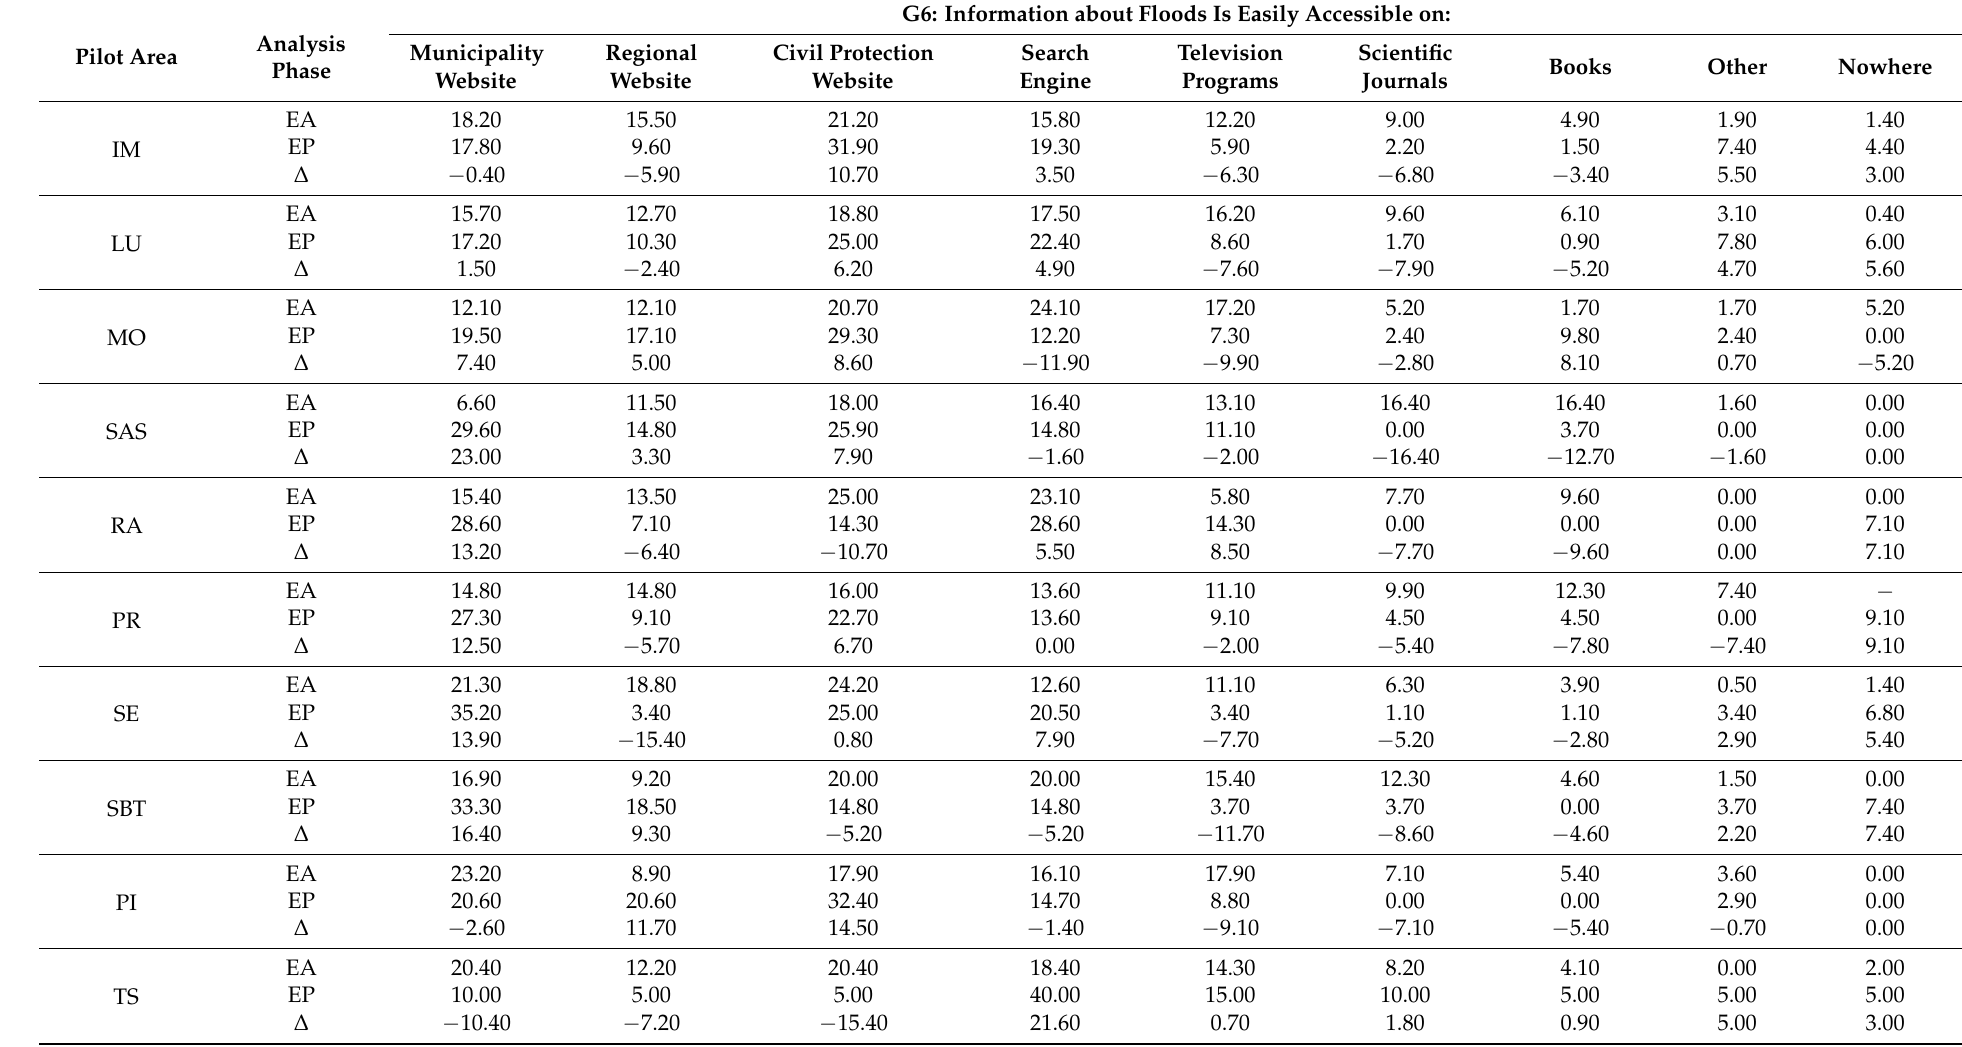
Table A7. Answers to the question G6 in percentages per each pilot area, in the ex-ante (EA) and in the ex-post (EP) phases, and their variation ( ∆ ).